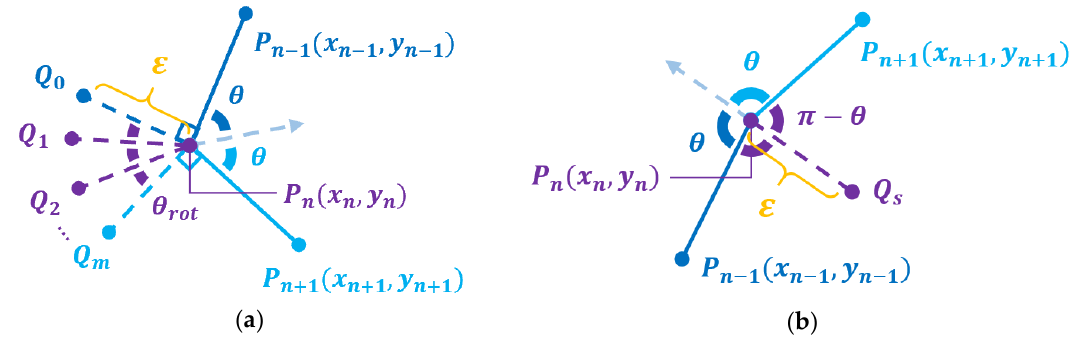
Figure 4. Detailed process of the EDP: ( a ) Convex; ( b ) Concave.